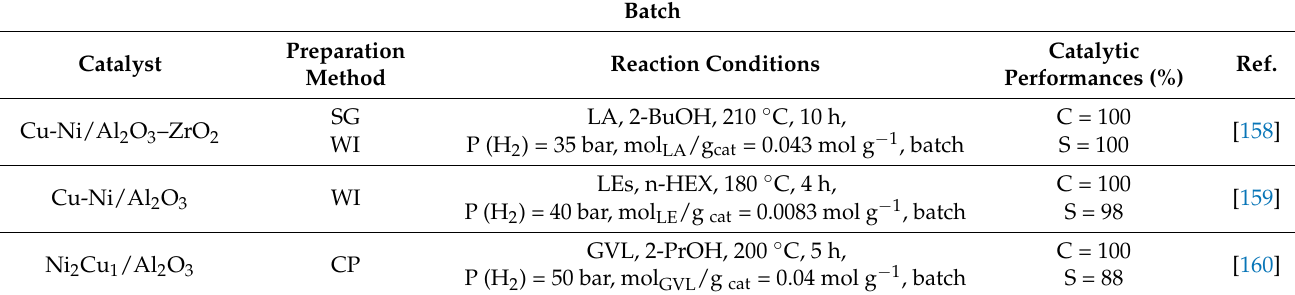
Table 5. Most relevant copper catalysts used for hydrogenation of LA/LEs or GVL to give 2-MTHF from the